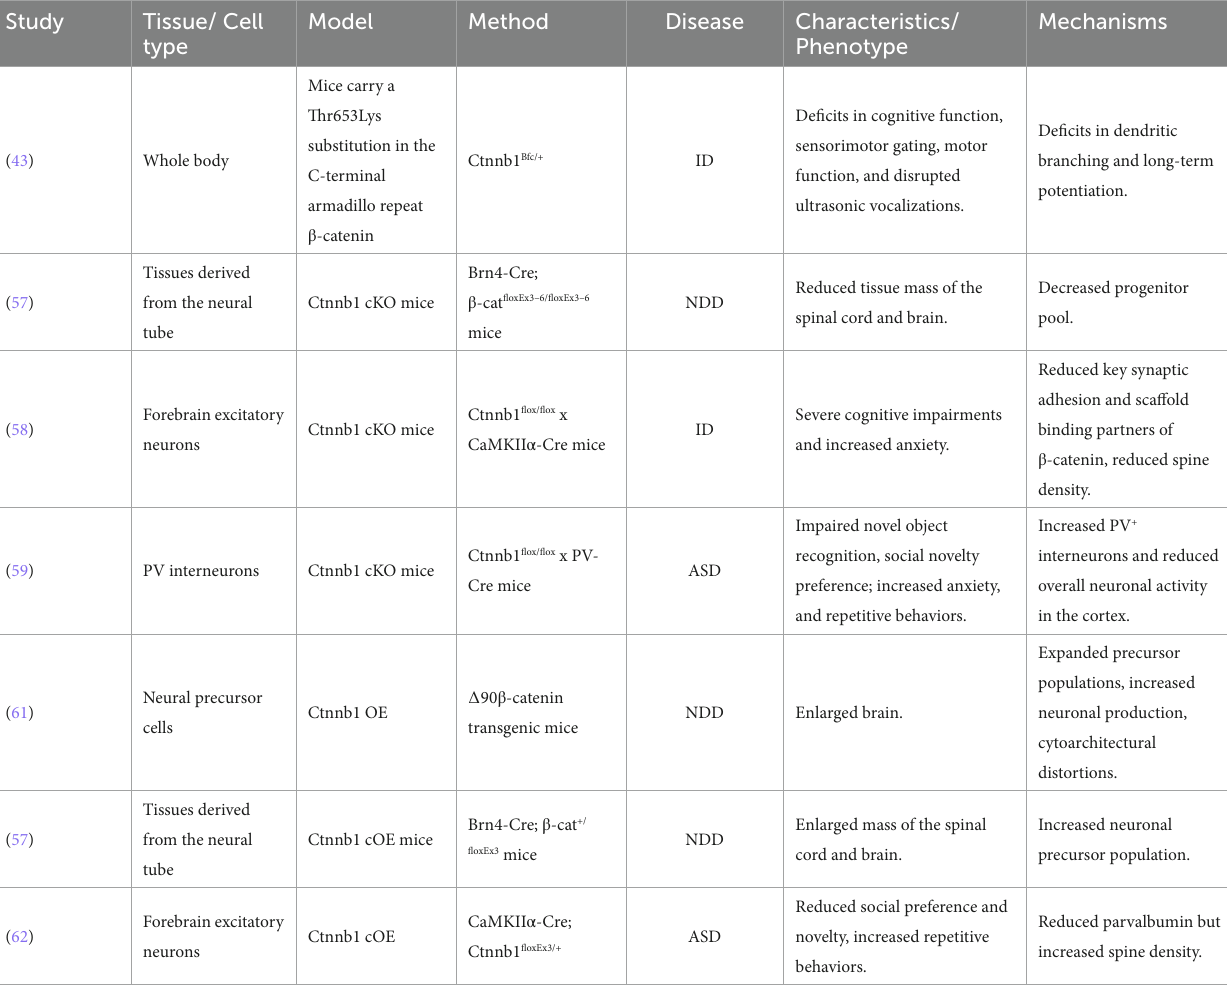
TABLE 2 Summary of Ctnnb1 deficiency and over-expression animal